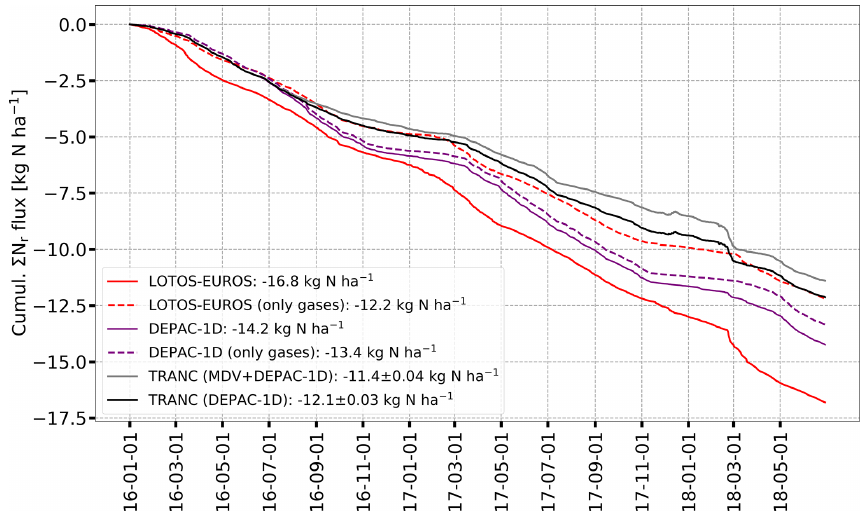
Figure 7. Comparison of measured and modeled cumulative (cid:54) N r dry deposition after gap filling for the entire measurement campaign. Colors indicate different methods: TRANC + DEPAC-1D (black), TRANC + MDV + DEPAC-1D (gray), DEPAC-1D (purple), and LOTOS- EUROS (red). Dashed lines refer to cumulative dry deposition considering only gases. Number shown in the legend represent dry deposition and uncertainties after 2.5